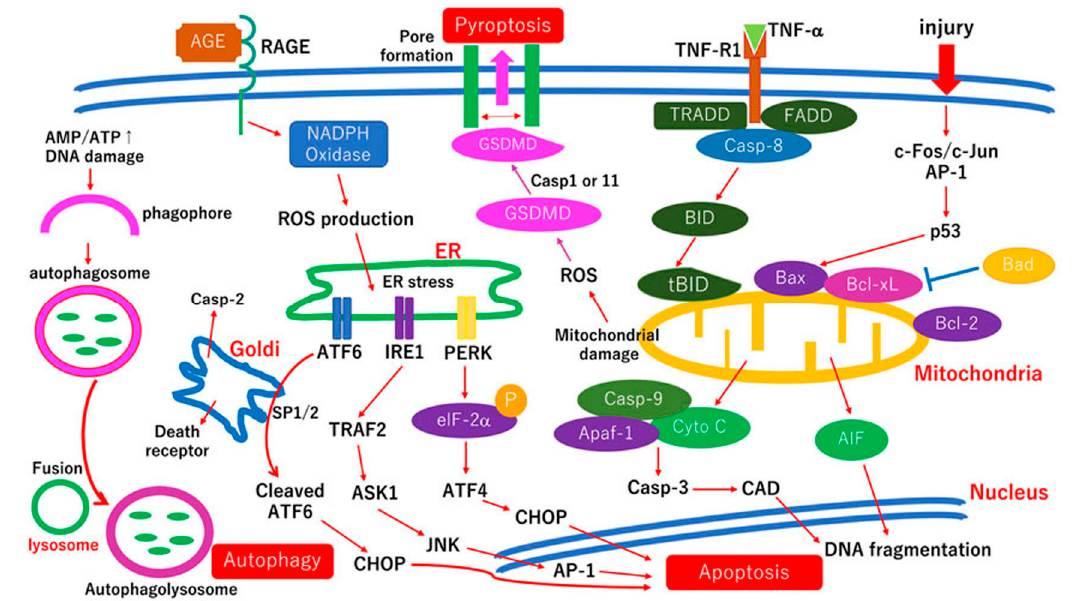
Figure 3. Hypothetic cell death pathways of RGCs under diabetic stress. Diabetic stress includes hyperglycemia, AGEs signaling, oxidative stress, excitotoxicity, and polyol pathway. These biochemical injuries are similar to physical injuries. In fact, some cell death mechanisms of biochemical injuries are, in part, common with those of physical injuries. Thus, the scheme partly includes evidence derived from optic nerve injury models and retinal culture studies. In cultured retinas, c-Fos is essential for neuronal apoptosis after injury [82]. C-Fos transfers the cell death signals to mitochondria by p53 upregulation resulting in Bax upregulation and Bcl-xL downregulation [82]. C-Jun is a partner of c-Fos and makes heterodimer activator protein-1 (AP-1). Retinas exposed to high glucose activate c-Jun and JNK in neurons in the ganglion cell layer [13]. Thus, the c-Fos/c-Jun (AP-1)/JNK signaling axis is related to neuronal cell death under diabetic stress [13]. Caspase -8, -9, and -3 are associated with neuronal cell death [83]. In fact, overexpression of Bcl-xL rescues damaged retinal ganglion cells [84]. In AGEs exposed retina, caspase-9, and apoptosis-inducing factor (AIF) expression are correlated with increasing neuronal cell death [11]. Thus, both caspase-dependent and caspase-independent pathways are associated with the AGE-induced neuronal cell death [11]. The AGE-RAGE signaling results in increasing the production of ROS which leads to ER stress-induced apoptosis. In fact, taurine-conjugated ursodeoxycholic acid (TUDCA) and anti-ER stress reagents reduce neuronal cell death in AGE-exposed retinas [16]. ROS production is also associated with pyroptosis via cleavage of GSDMD by caspase-1 or -11. Autophagy signaling is usually regulated by the mammalian target of rapamycin (mTOR) pathway under physiological conditions. Under diabetic stress, the intrinsic survival pathway should be decreased resulting in activation of autophagy signaling. Over activation of autophagy signaling may cause to autophagic cell death. TNF- α , tumor necrosis factor- α ; TRADD, TNF receptor 1-associated death domain protein; FADD, Fas-associated death domain; TRAF2, TNF receptor-associated factor 2; Casp8, caspase-8; tBID, truncated Bid; Bcl-2, B-cell lymphoma 2; Bcl-xL, B-cell lymphoma-extra large; Casp-9, caspase-9; Apaf-1, Apoptosis protease-activating factor 1; cyto c, cytochrome c; ROS, reactive oxygen species; GSDMD, Gasdermin D; CAD, Caspase-activated DNase; AP-1, activator protein-1; ER, endoplasmic reticulum; PERK, protein kinase-like ER eukaryotic initiation factor-2alpha kinase; IRE1, inositol-requiring ER-to-nucleus signaling protein 1; ATF6, activating transcription factor-6; CHOP, CCAAT/enhancer-binding protein homologous protein; JNK, c-Jun N -terminal kinase; elF-2 α , Eukaryotic Initiation Factor-2 α ; AGEs, advanced glycation end-products; RAGE, receptor for AGEs; NADP, nicotinamide adenine dinucleotide phosphate (NADP+ oxidized form; NADPH reduced form); AMP, adenosine monophosphate, ATP, adenosine triphosphate.